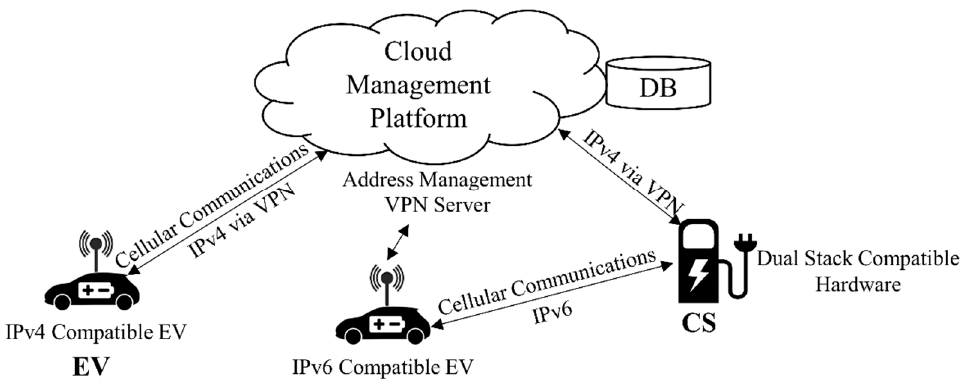
Figure 6. A reference architecture for the OPC–UA implementation.